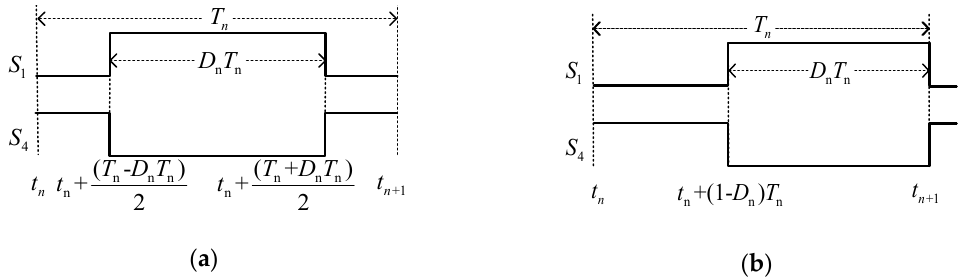
Figure 2. The PWM pulse is located at ( a ) the center of switching cycle; ( b ) the back of switching cycle.